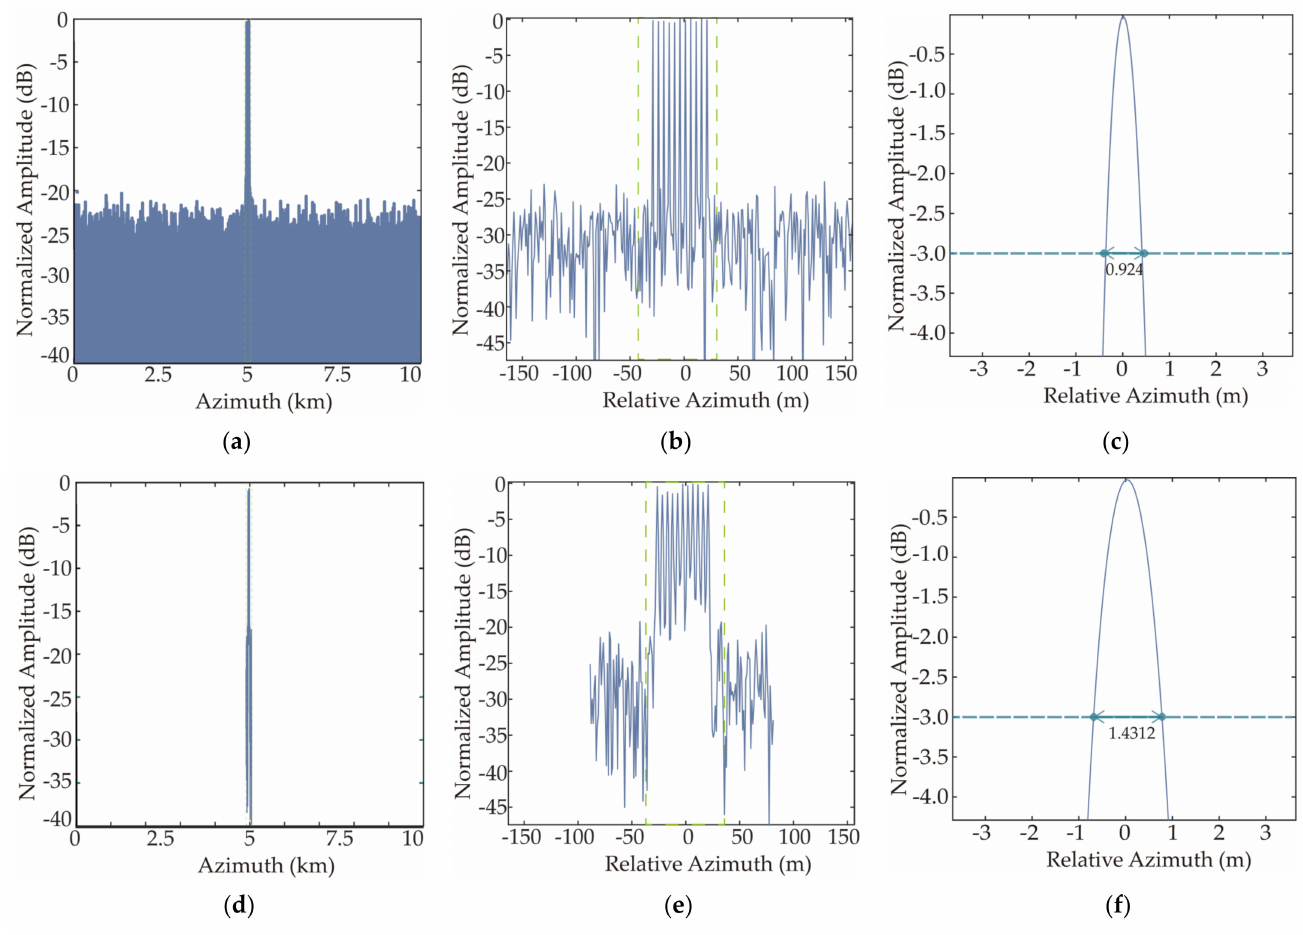
Figure 15. Imaging results in the azimuth direction. ( a ) Result of the current framework; ( b ) enlarged target’s area in ( a ); ( c ) interpolated peak of the center point in ( b ); ( d ) result of the proposed framework; ( e ) enlarged target’s area in ( d ); ( f ) interpolated peak of the center point in ( e